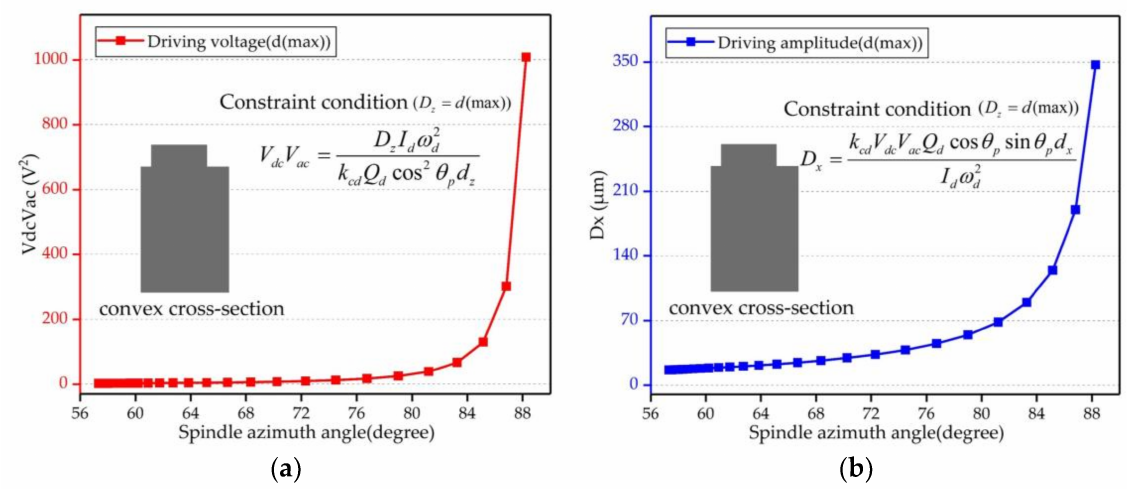
Figure 4. Driving voltage and driving amplitude of the convex cross-section beam, when the in-plane displacement was fixed at d ( max ) ; ( a ) shows the required driving voltages of different spindle azimuth angles; ( b ) shows the corresponding driving amplitudes of different spindle azimuth